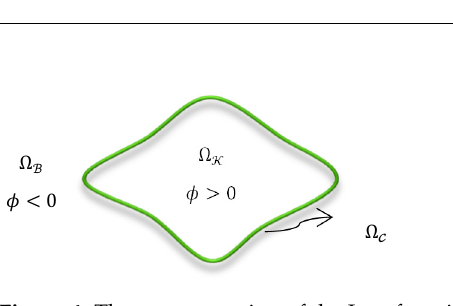
Figure 4. The representation of the Lset function in the image domain.